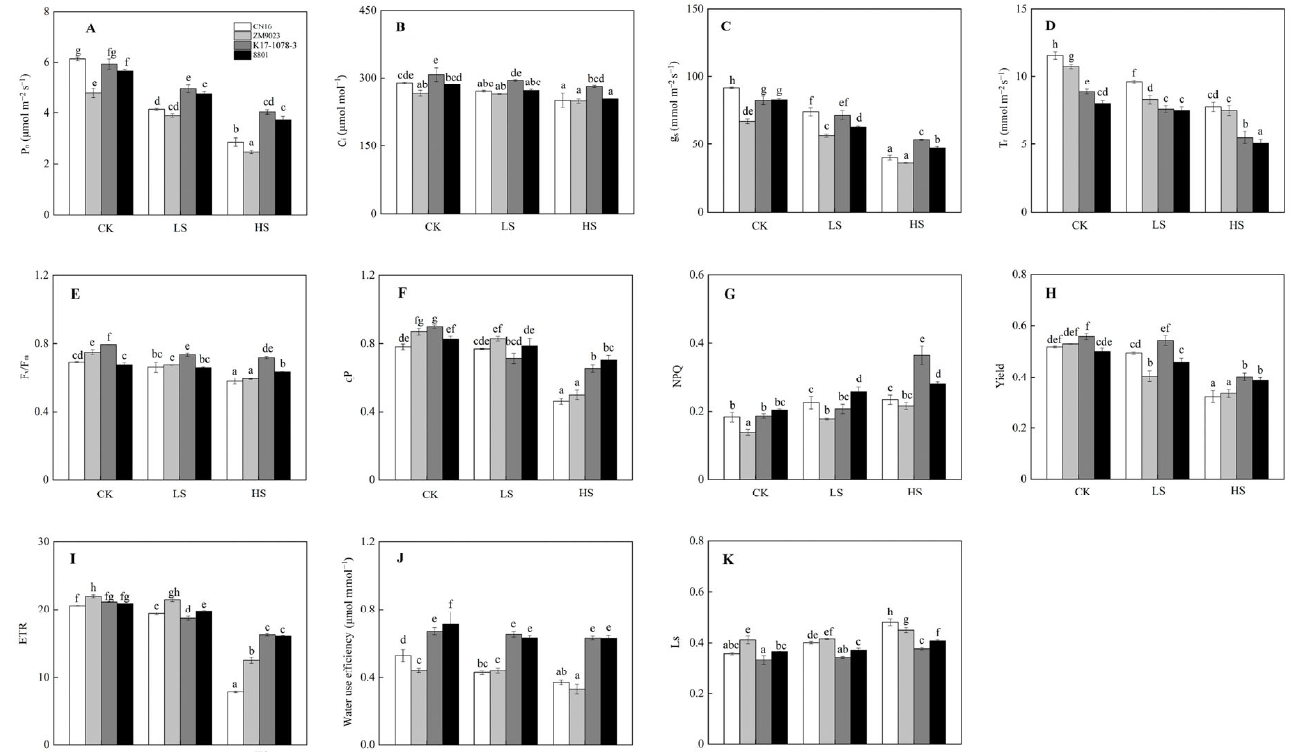
Figure 3. P n ( A ); C i ( B ); g s ( C ); T r ( D ); F v /F m ( E ); qP ( F ); NPQ ( G ); yield ( H ); ETR ( I ); water use efficiency ( J ); and L s ( K ) variations in K17-1078-3 and its parents subjected to different salinity levels. Different letters indicated significant difference due to salt treatments according to Duncan’s multiple range tests. CK, LS, and HS referred to NaCl concentrations of 0, 50, and 200 mM. Salinity significantly increased the Na + content in shoots and roots. CN16 and ZM9023 had higher Na + accumulation in shoots under HS treatment and in roots under LS and HS treatments than K17-1078-3 and 8801 (Figure 4). Meanwhile, K17-1078-3 had significantly higher K + content in shoots than that of the other three wheat genotypes, and maintained a lower decline in K + content of roots compared to CN16 and ZM9023 under LS and HS treatments (Figure 4). Na + /K + ratio followed a similar pattern to Na + content in shoots and roots. K17-1078-3 and 8801 had a consistently lower Na + /K + ratio in roots under LS and HS treatments and in shoots only under HS treatment than CN16 and ZM9023. Moreover, HS treatment significantly increased the Pro content in shoots and roots compared to CK condition, with K17-1078-3 and 8801 showing higher than CN16 and ZM9023. There was no significant difference in the Pro content of K17-1078-3 and 8801 between CK and LS treatments (Figure 4). Compared with CN16 and ZM9023, K17-1078-3 and 8801 had significantly lower relative conductivity in shoots and roots under HS treatment, and there was no difference in shoots among them under LS treatment. No significant change in relative conductivity was observed in both shoots and roots of K17-1078-3 and 8801 under LS and HS